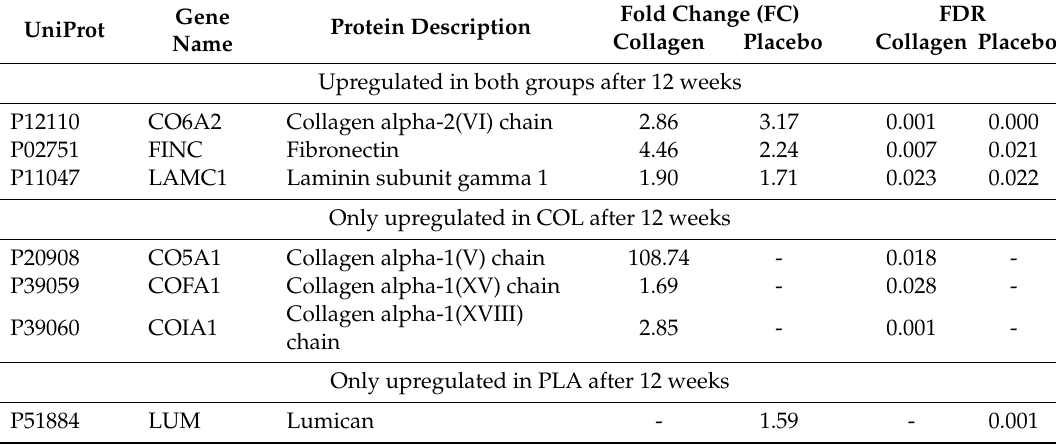
Table 6. Upregulated proteins from the intersection, collagen (COL), and placebo (PLA) groups belonging to collagen proteins or collagen-associated